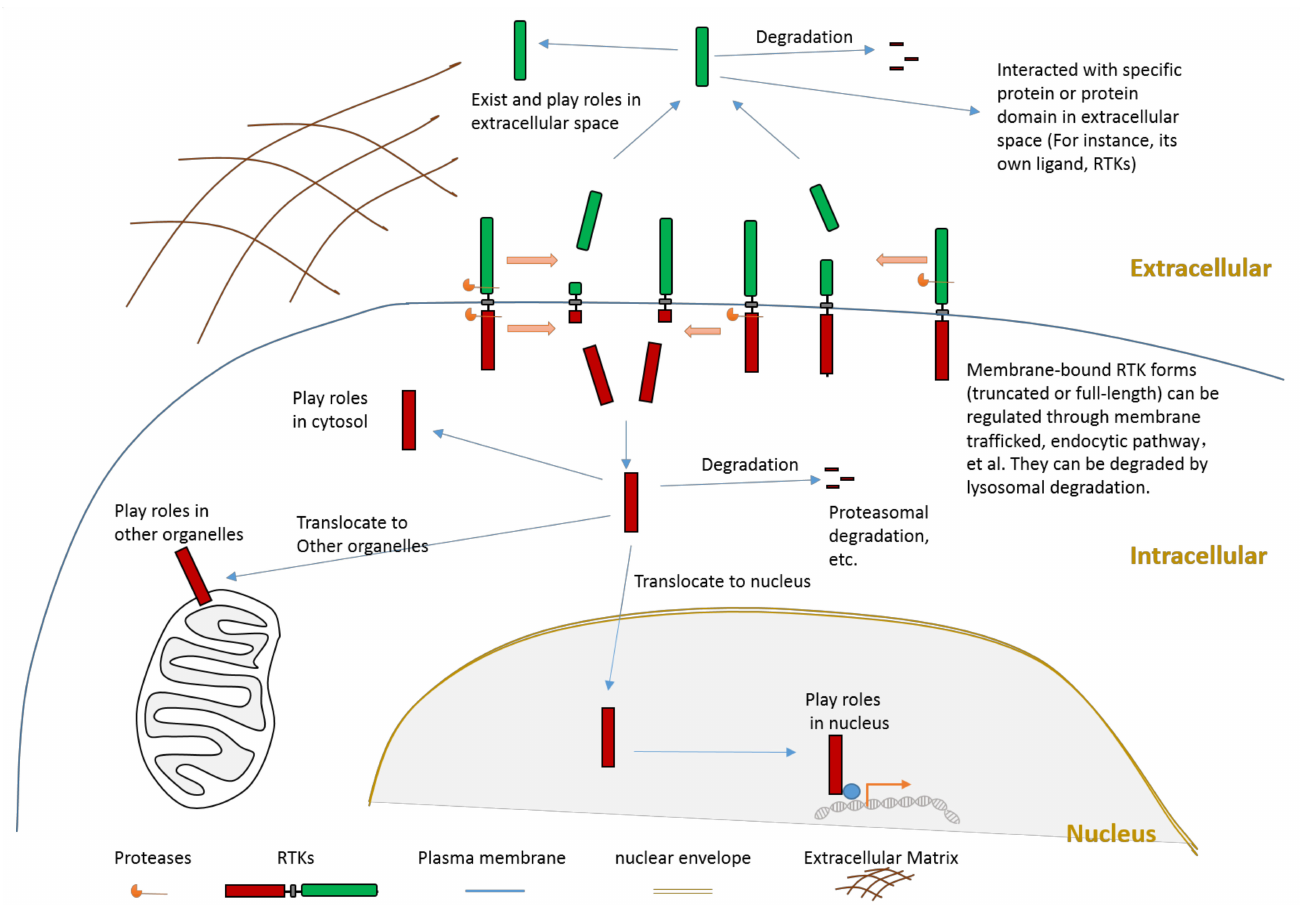
Figure 2. Schematic illustration about the consequences of RTK proteolytic